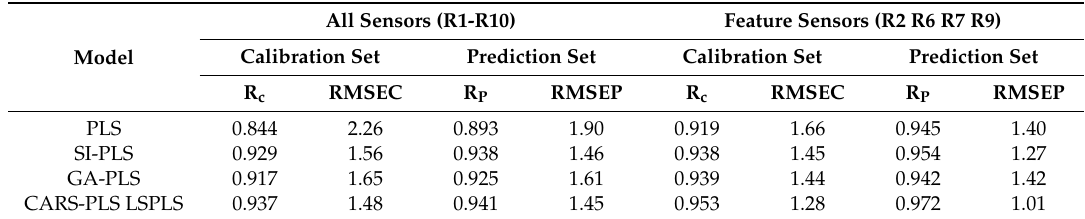
Table 3. Results of an optimal PLS model using di ff erent data based on di ff erent variable selection